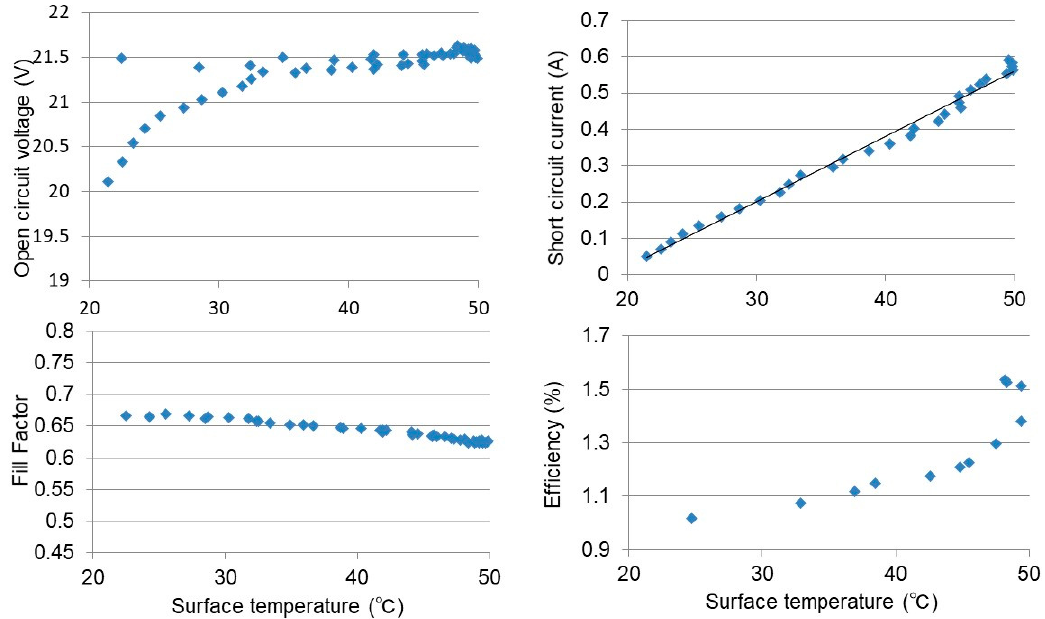
Figure 7. Power generation performance of OPV sheet as a function of temperature for large-scale solar chimney.